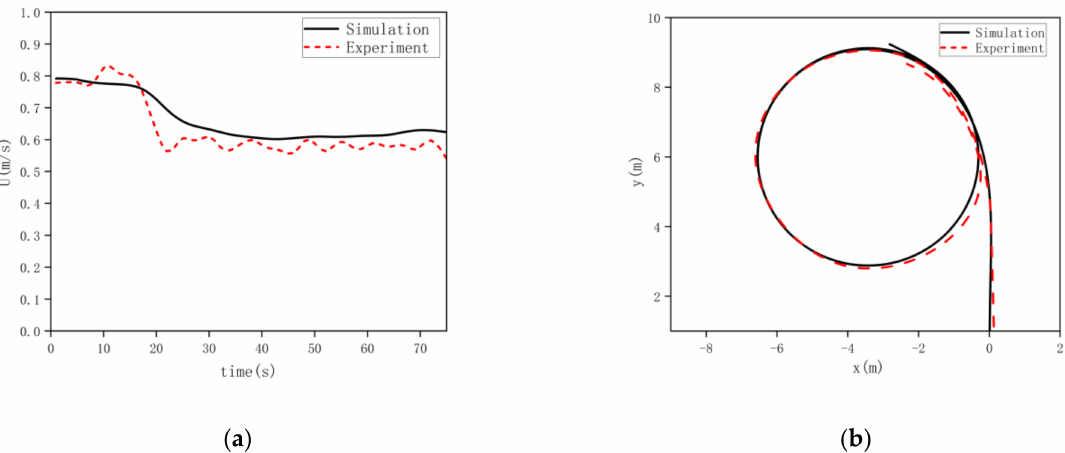
Figure 10. Comparison of the prediction and experiment in the 30 ◦ turning circle. ( a ) Speed compari- son. ( b ) Track